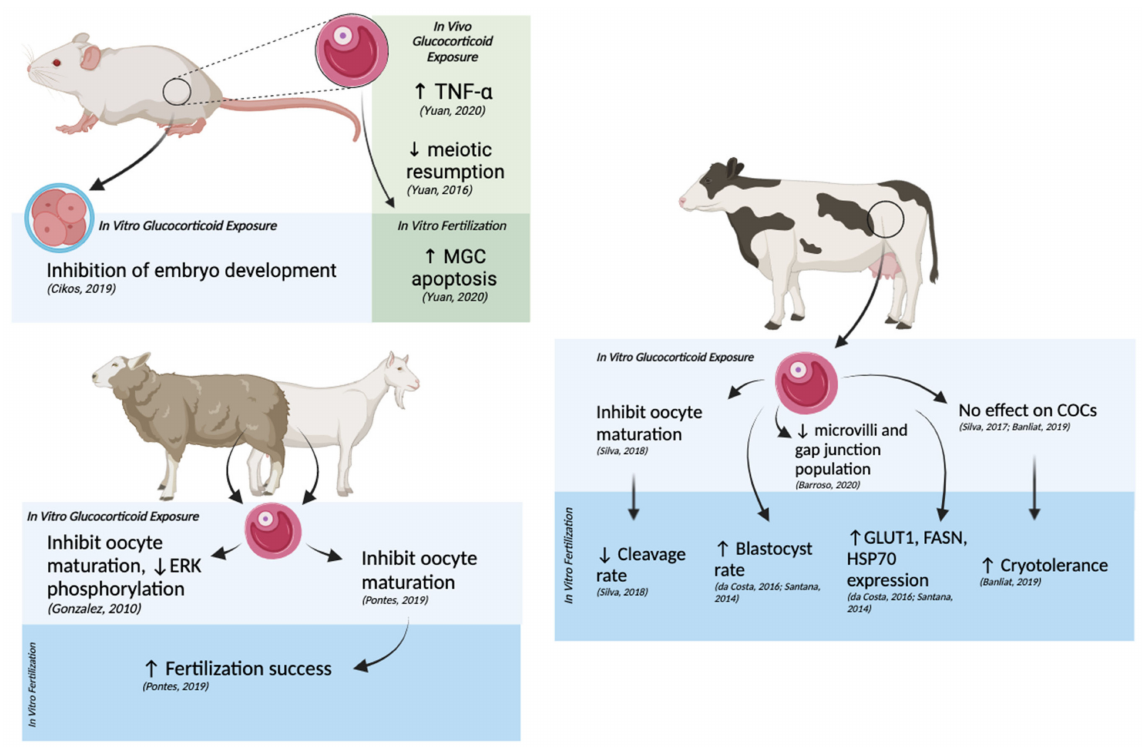
Figure 5. Outcomes of in vivo and in vitro glucocorticoid exposure in oocytes and embryos from mice, lamb, goat, and cow models. Glucocorticoid inhibition of oocyte maturation in vitro is observed in all animal models. Glucocorticoid exposure in mouse embryos inhibited development, while maternal exposure to glucocorticoids caused increased apoptosis in granulosa cells of subsequent embryos. In goats and cows, maternal glucocorticoid exposure increased fertilization success in goats and blastocyst rate in cows, though da Silva et al. (2018) also report a decrease in cleavage rate in cow embryos